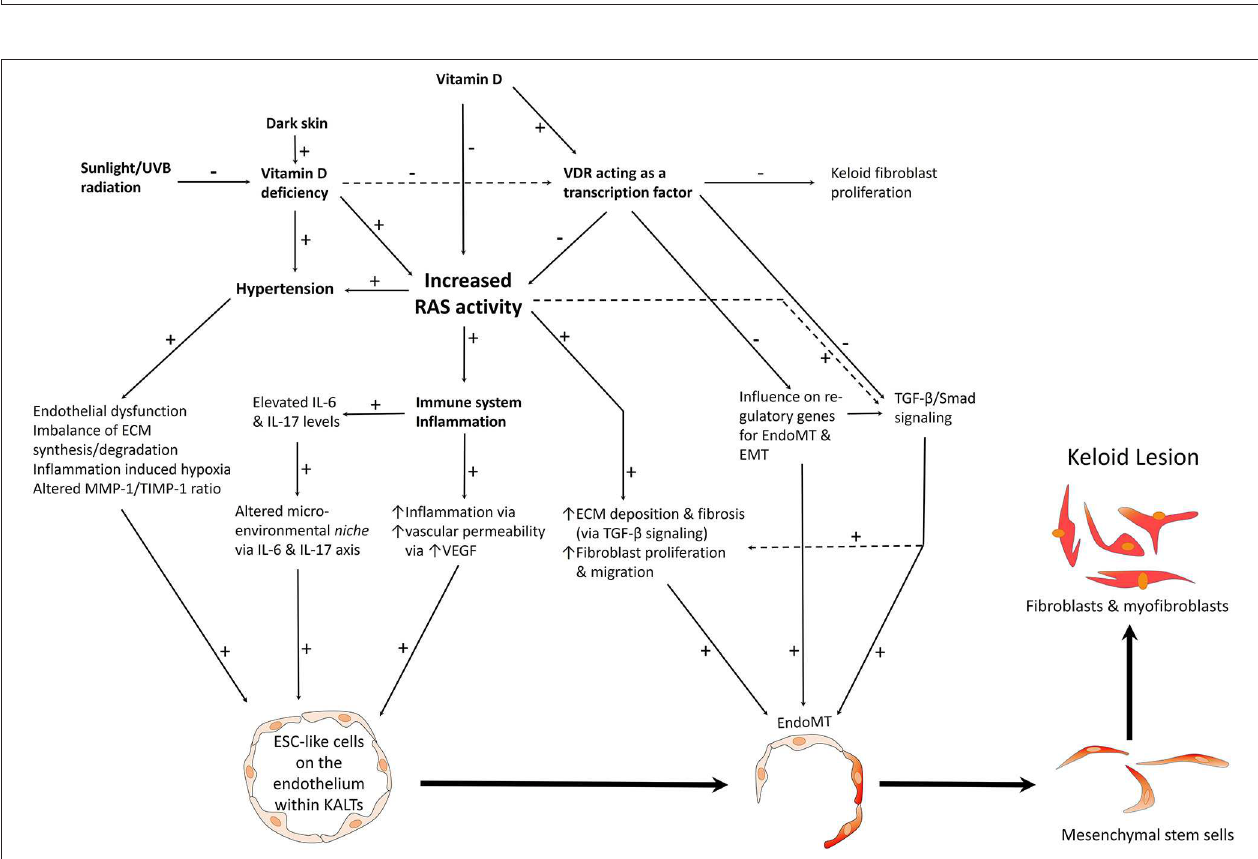
FIGURE 2 | A proposed model of keloid disorder showing embryonic stem cell (ESC)-like cells within keloid-associated lymphoid tissues (KALTs), regulated by a microenvironmental niche with resultant proliferation and accumulation of fibroblasts and myofibroblasts in the keloid lesion (KL) via a mesenchymal stem cell intermediate through an endothelial-to-mesenchymal transition (endo-MT). The renin-angiotensin system (RAS) plays a central role in the microenvironmental niche with complex interactions with the immune system/inflammation, vitamin D, vitamin D deficiency (VDD), vitamin D receptor (VDR), and hypertension. VDD which is caused by reduced sunlight/UVB radiation, and leads to increased RAS activity and the resultant hypertension. VDD also directly leads to hypertension. Increased RAS activity also activates the immune system. The complex interactions between these elements lead to activation of various pro-fibrotic signaling pathways leading to generation of fibroblasts and myofibroblasts. Hypertension has a direct pro-fibrotic effect and contributes to the conducive microenvironment for the ESC-like cells within the KALTs. VDD increases RAS activity, with activation of the immune system/inflammation leading to an altered microenvironmental niche via the IL-6 and IL-17 axis. This increased RAS activity activates TGF- β /Smad signaling to promote EndoMT. Binding of vitamin D to VDR results in a genomic effect which counteracts the profibrotic signaling pathways. VDR transcriptional activity inhibits keloid fibroblast proliferation. VDR transcriptional activity also inhibits the pro-fibrotic TGF- β /Smad signaling pathway, down-regulates genes for EndoMT, and so may influence the formation of fibroblasts and myofibroblasts within KLs. ECM, extracellular matrix; TGF- β , transforming growth factor- β ; MMP-1, matrix metalloproteinase-1; TIMP-1, tissue inhibitor of metalloproteinase-1; IL, interleukin; UVB, ultraviolet B; VEGF, vascular endothelial growth factor. “ + ” signifies a positive effect; “ − ” signifies a negative effect.